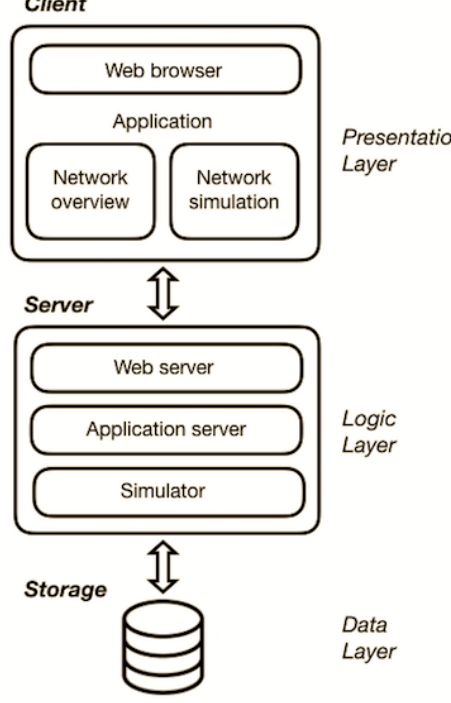
Figure 4. The solution 3-tier